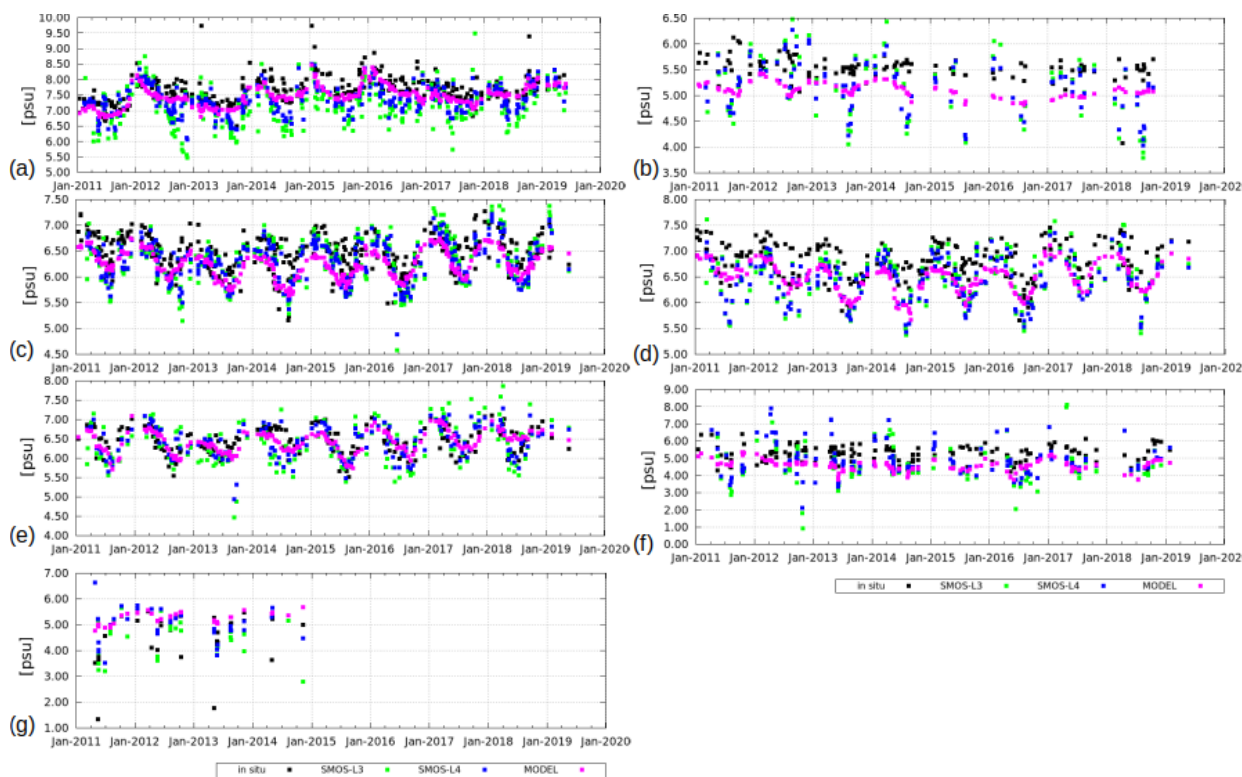
Figure 24. Spatiotemporal collocations of Baltic+ L3 SSS, Baltic+ L4 SSS, CMEMS Baltic reanalysis salinity fields with in situ salinity. Regions: (a) Bornholm Basin (BB), (b) Bothnian Sea (BS), (c) northern Baltic Proper (NBP), (d) eastern Gotland Basin (EGB), (e) western Gotland Basin (WGB), (f) Gulf of Finland (GOF) and (g) Gulf of Riga